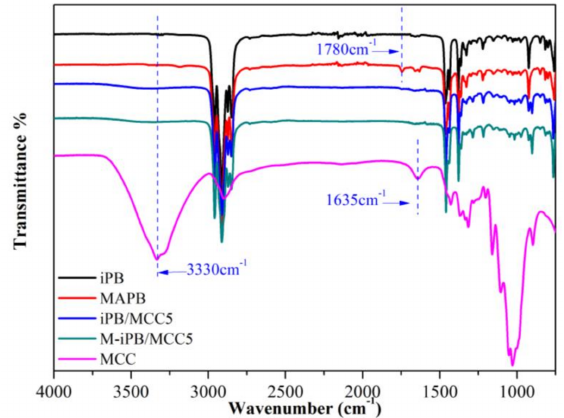
Figure 2. Figure 2 FTIR spectrum of the samples.